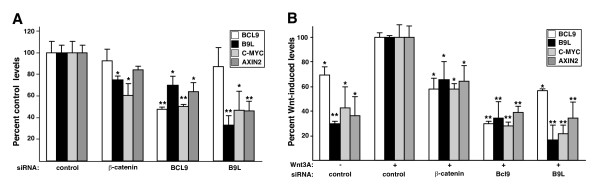
BCL9 is required for the transcription of endogenous Wnt target genes. Transcript levels of BCL9, B9L, c-MYC and AXIN2, as measured by RT-qPCR, in (A) SW480 cells or (B) Wnt-induced HEK 293 cells (as in Fig. 3), treated with siRNA to deplete β-catenin, BCL9 or B9L. Statistical significance (*, p < 0.01 and **, p < 0.001) relative to controls (set arbitrarily to 100%) is indicated above bars.